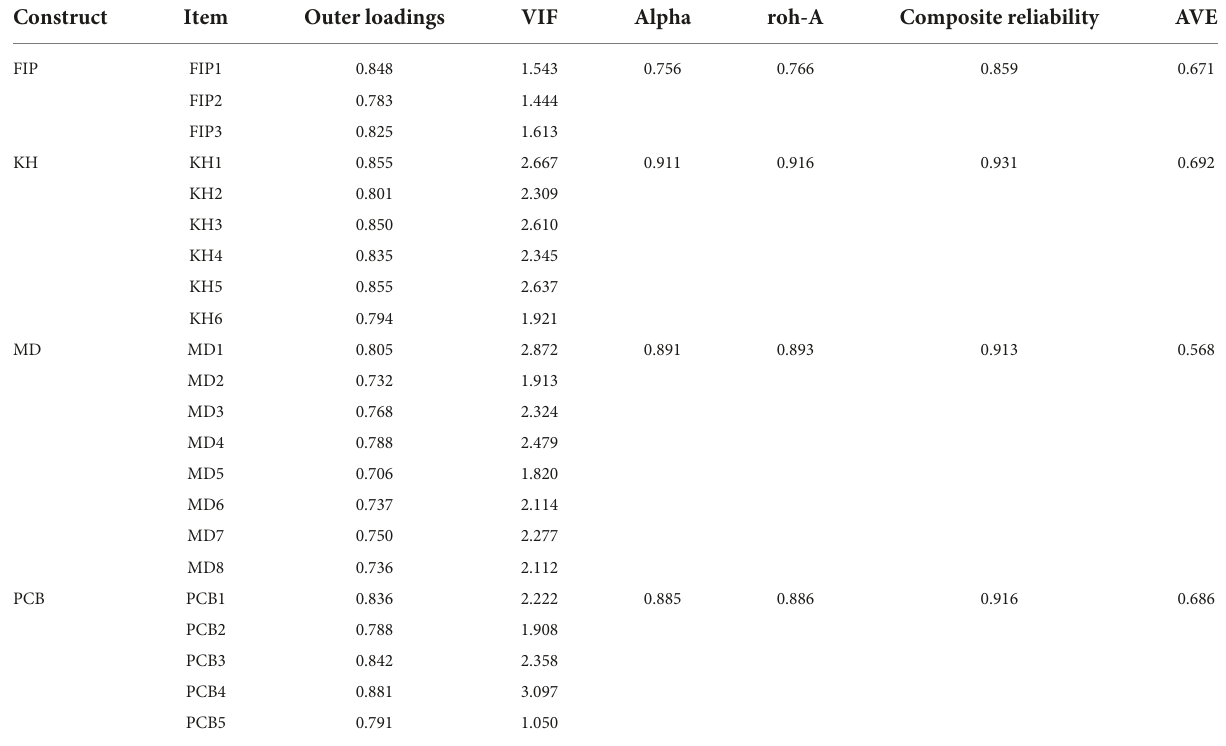
TABLE 1 Reliability and convergent validity of the study constructs (mediation).